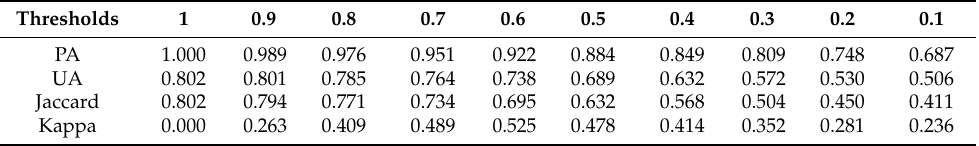
Table 3. Kudzu classification performance based on linear unmixing after the phenology-based masking. Thresholds